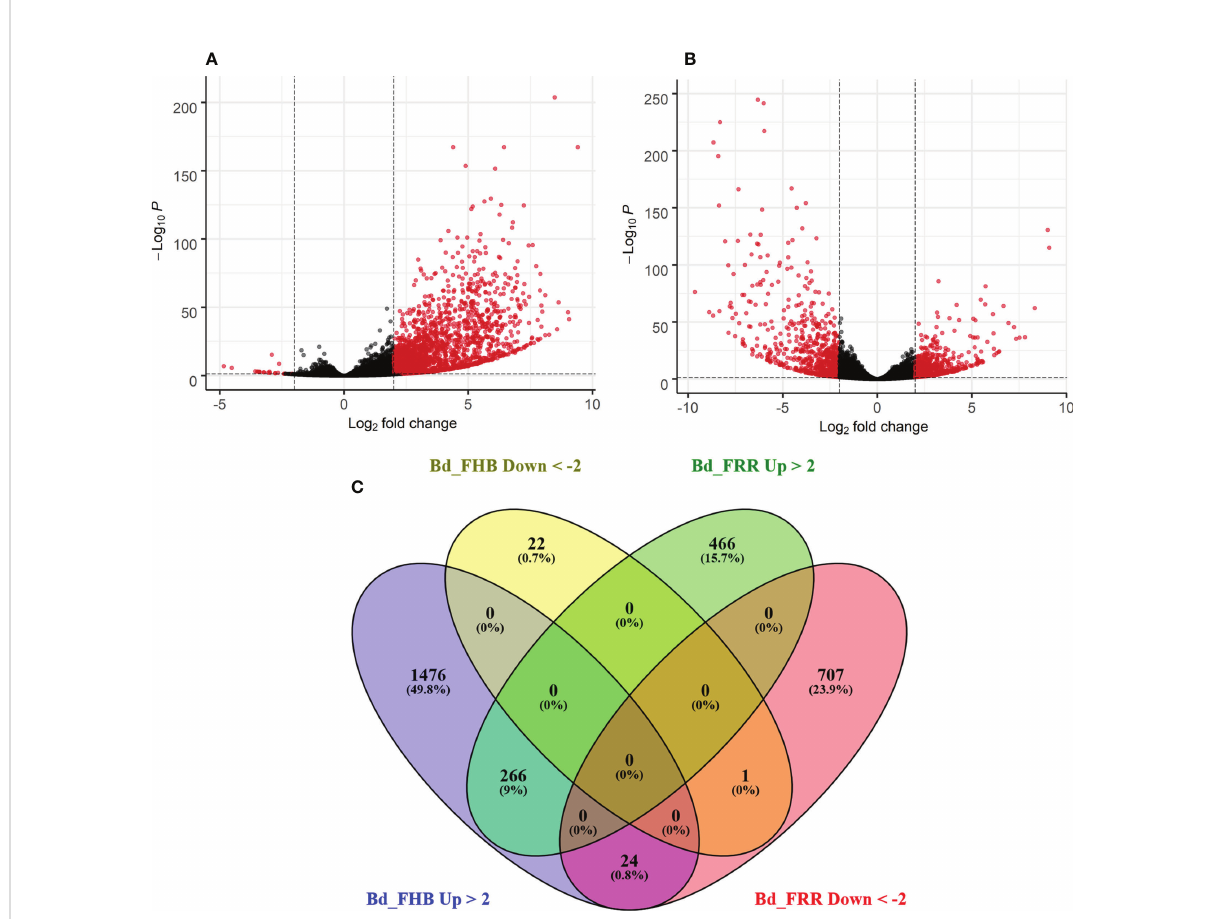
FIGURE 1 Summary of expression of B. distachyon genes in response to FHB and FRR. (A) Differential gene expression in response to FHB. (B) Differential gene expression in response to FRR. (A, B) Each dot represents a gene (Supplementary Table S3), excluding those without a p-adj value. The y- axis is the -Log10 of the p-adj value (p-adj < 0.05) denoted by a dotted line. The x-axis is the Log2 fold change with a cut-off of 2 denoted by two dotted lines. Thus a red dot denotes that a gene was statistically signi fi cantly differentially expressed. (C) A comparison of genes between FHB and FRR datasets. The threshold of -2 ≤ x ≥ 2 Log-fold change and p-adj < 0.05 was applied to all genes. Abbreviations: Bd ( B. distachyon ), Up (Upregulated), Down (Downregulated), FRR (Fusarium Root Rot), FHB (Fusarium Head